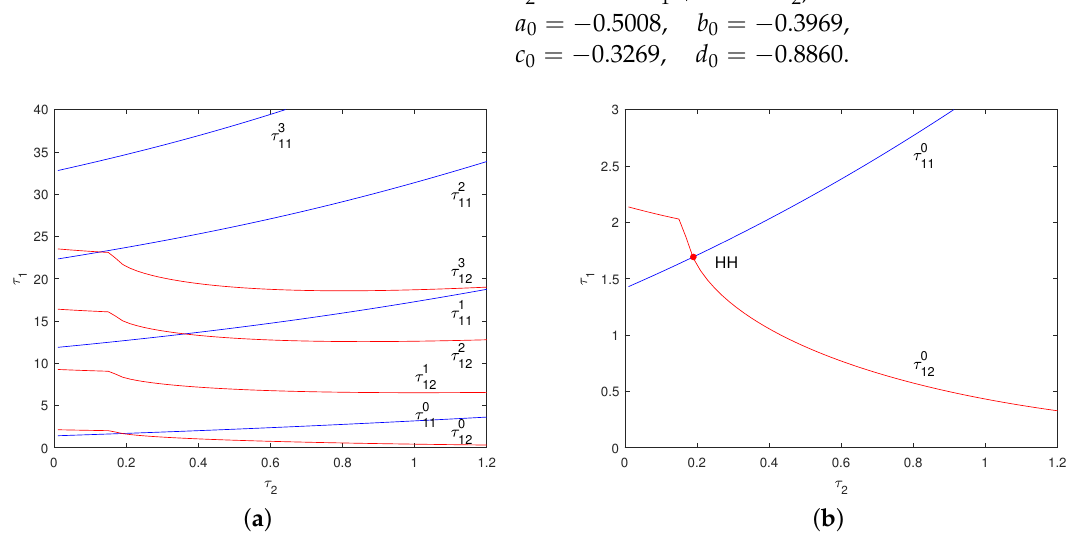
Figure 4. When k = − 0.5, β = 0.4, l = 0.5, ( a ) is the bifurcation set diagram with τ 2 as the x -axis and τ 1 as the y -axis, and ( b ) is the partial enlarged diagram and the double Hopf bifurcation